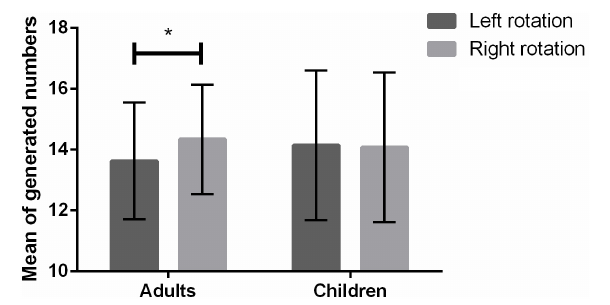
FIGURE 1 | Mean of generated numbers as a function of left/right rotation in adults and children. Error bars represent standard deviation. Asterisks denote statistical significance ( ∗ p <